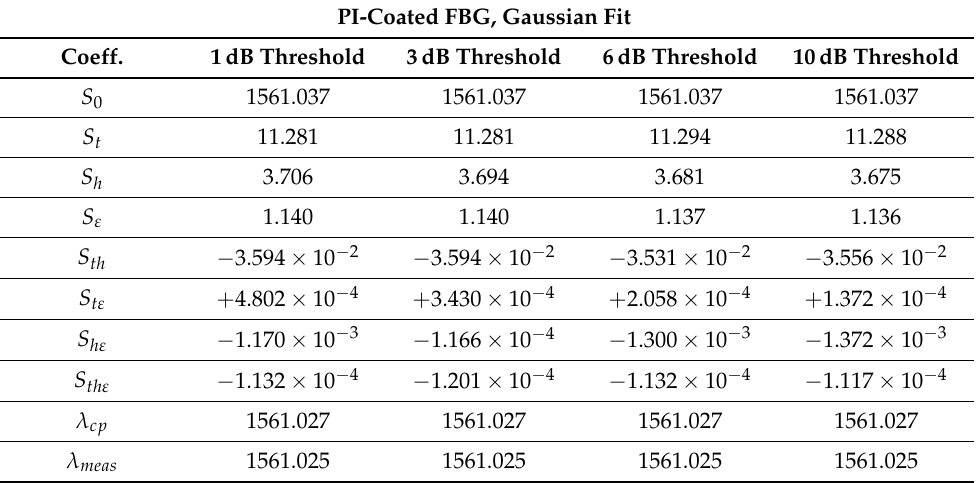
Table 6. Main and interaction sensitivities of PI-coated FBG, calculated using factorial design using Gaussian fit.